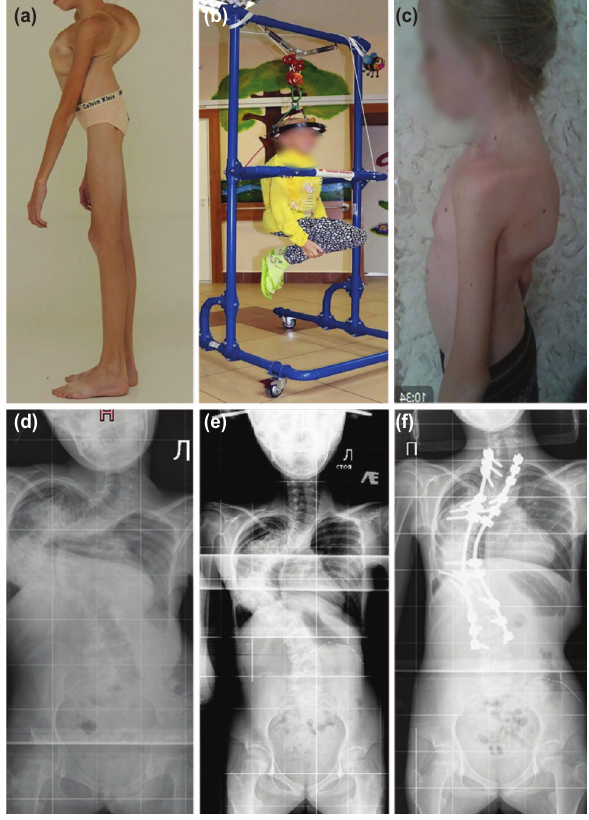
7-year old patient with undifferentiated connective-tissue Fig. 1: dysplasia (Case 1). Images (a) pre-operative, (b) on traction and (c) post-operative. Radiographs (d) pre-operative, (e) on traction and (f) post-operative.